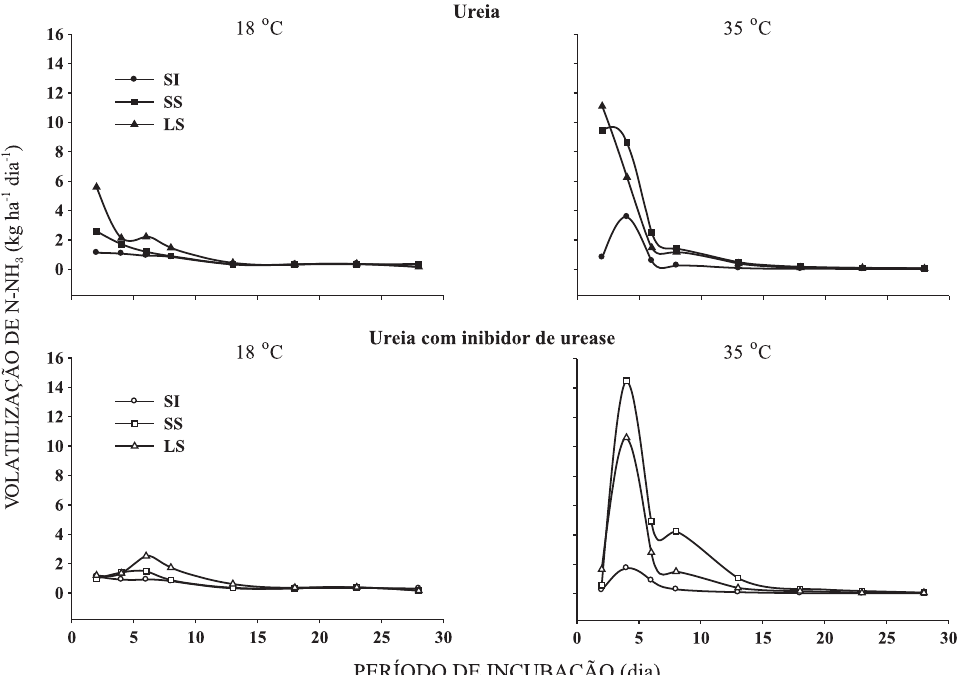
Figura 2. Volatilização diária de NH do solo ao longo do tempo após a aplicação de ureia convencional (U) ou 3 de ureia com inibidor de urease (UIU) nas formas sólida, com (SI) ou sem incorporação (SS), ou líquida sobre a superfície (LS), em ambiente mantido a 18 ou a 35 o